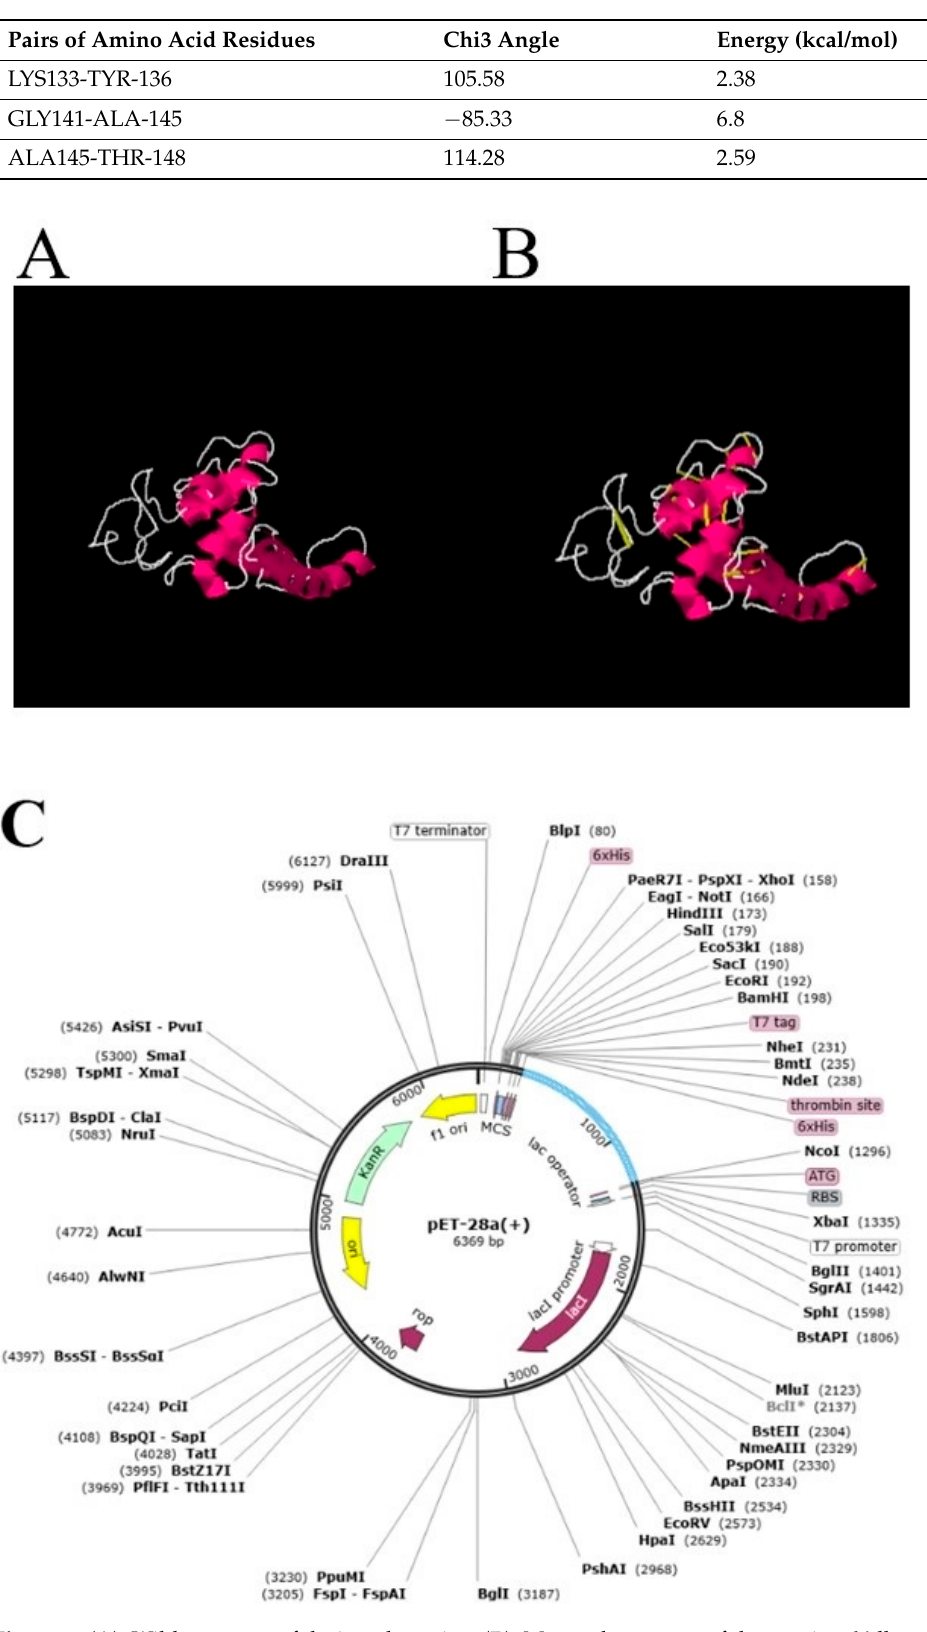
Figure 6. ( A ). Wild structure of designed vaccine, ( B ). Mutated structure of the vaccine. Yellow color stick shows mutation by cysteine amino acid. ( C ). in silico cloned pET28a vector.